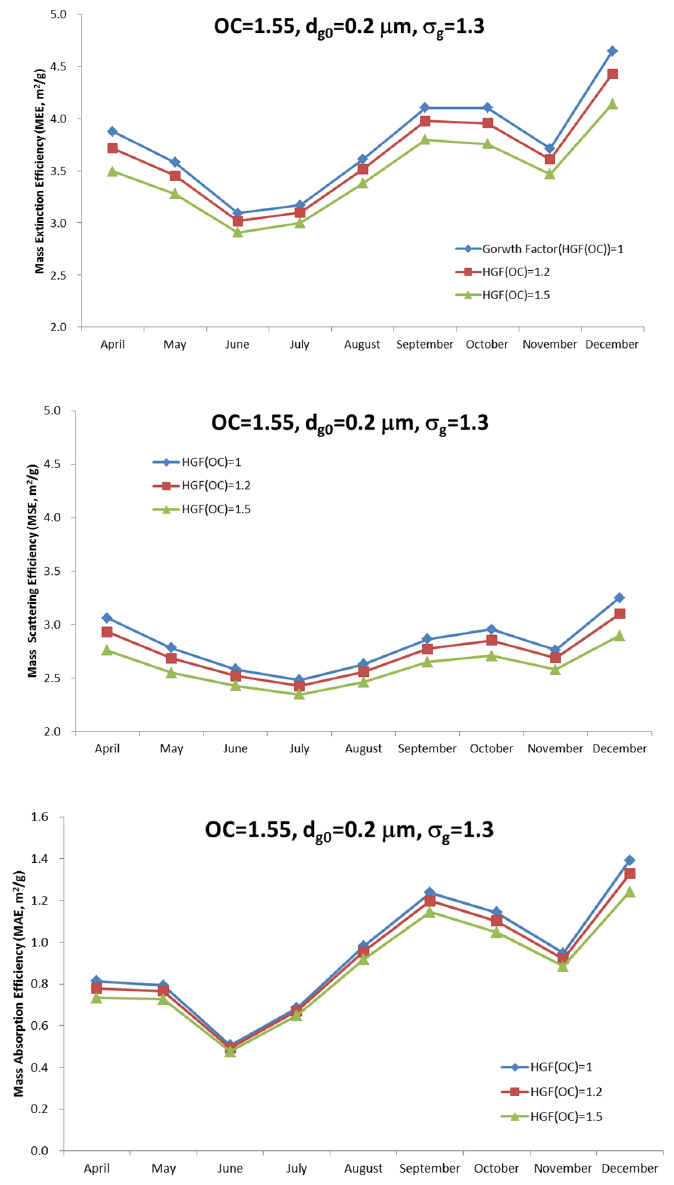
Figure 7. Comparison of the mass extinction efficiency, mass scattering efficiency and mass absorption efficiency of the total aerosol with different hygroscopic factors ( λ = 550 nm).